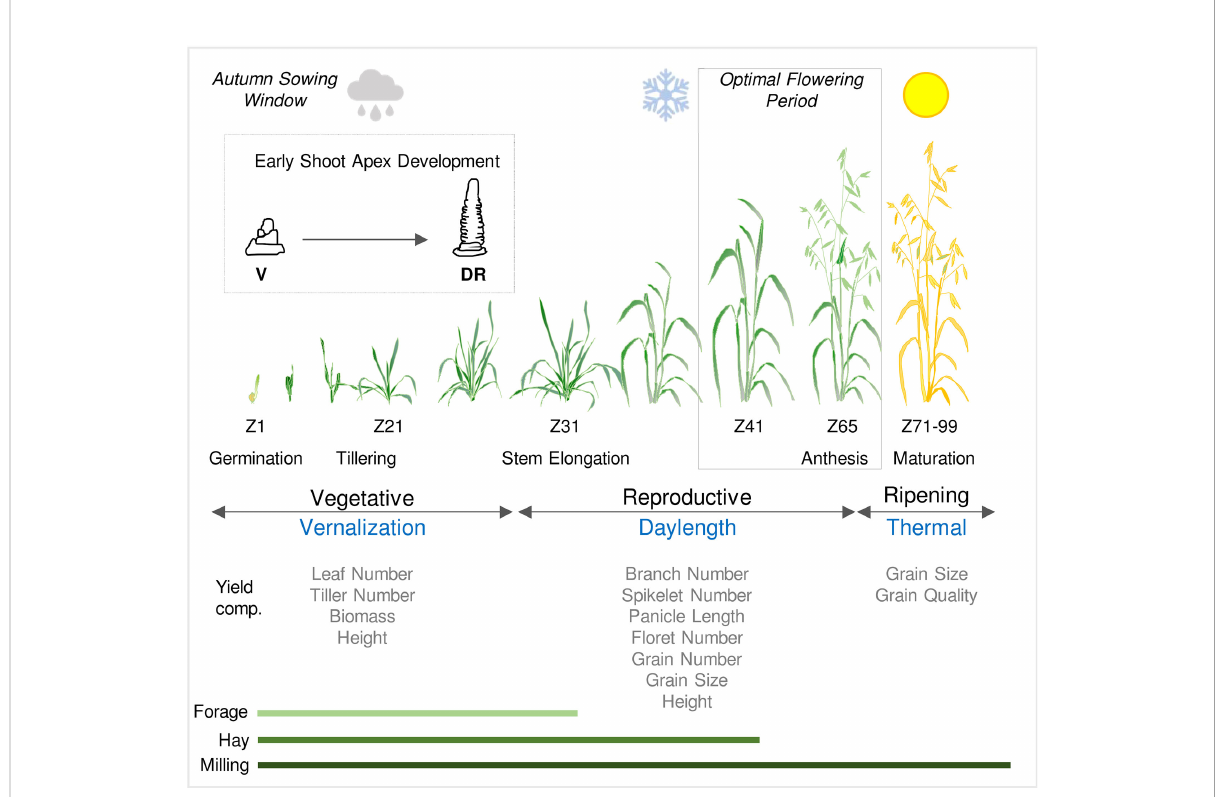
FIGURE 1 Schematic representation of the life cycle of oat in an Australian context. Sowing and establishment of crops is timed according to water availability in autumn (cloud symbol) and then plants experience cold temperatures through late autumn and winter (vernalization). Flowering and grain production occur during a optimal fl owering period in spring, after the risk of frost subsides (snow fl ake symbol) and before the onset of heat and water limitation (sun symbol). Developmental stages are referenced by Zadoks scale (Zadoks et al., 1974). Inset shows early shoot apex development and the fi rst visible sign of the transition from vegetative (V) to reproductive development; the double ridge stage (DR). The relationships between phases of development (vegetative and reproductive) and ripening are shown relative to the seasonal climate cues that in fl uence the duration of each these phases. The impact of phase durations on physiological and yield related traits are indicated together with the relevance of growth phases to different end uses (forage, hay or